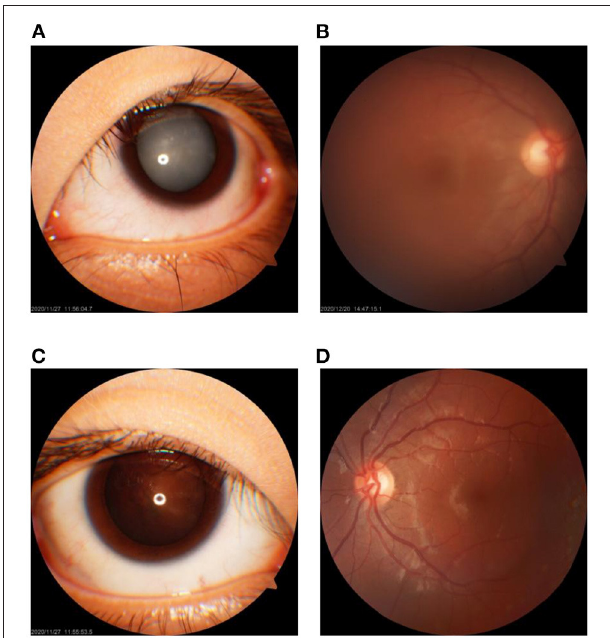
FIGURE 1 | Clinical feature of the cataracts in the 17-year-old male proband. (A,B) The cortical cataract of the lens and the fundus of the left eye, respectively. (C,D) The nuclear cataract of the lens of the right eye with cloudiness at the posterior lens capsule and the fundus of the right eye,